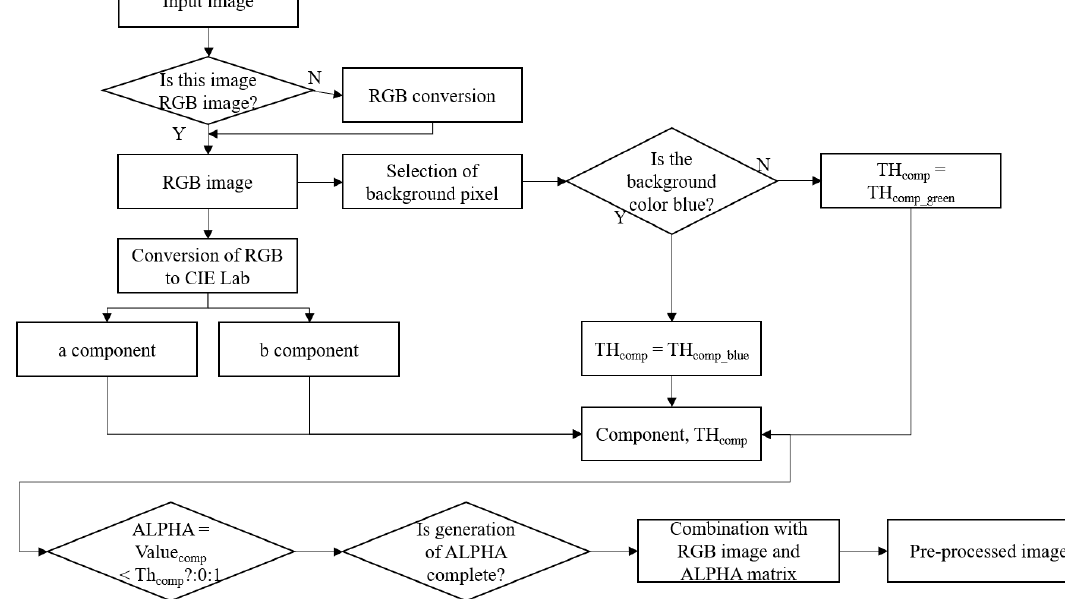
Figure 3. Process of background